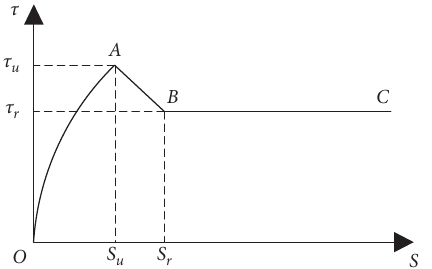
Figure 19: Simplified model of the τ − s curve of direct bond specimens.